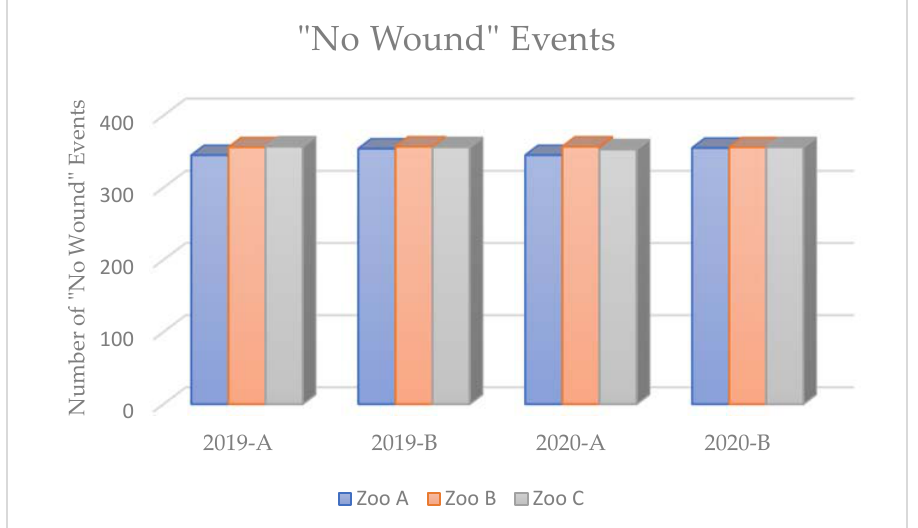
Figure 1. Number of “No Wound” Events across all Zoos and Time Conditions. Table 5. 1 × 4 Chi-Squares for the Three Zoos.